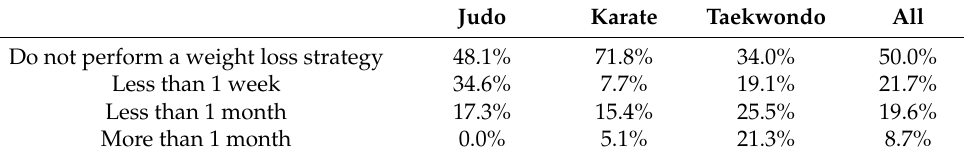
Table 1. General timeframe to lose weight before a competition (item 17 of the RWLQ: In how many days do you usually cut weight before